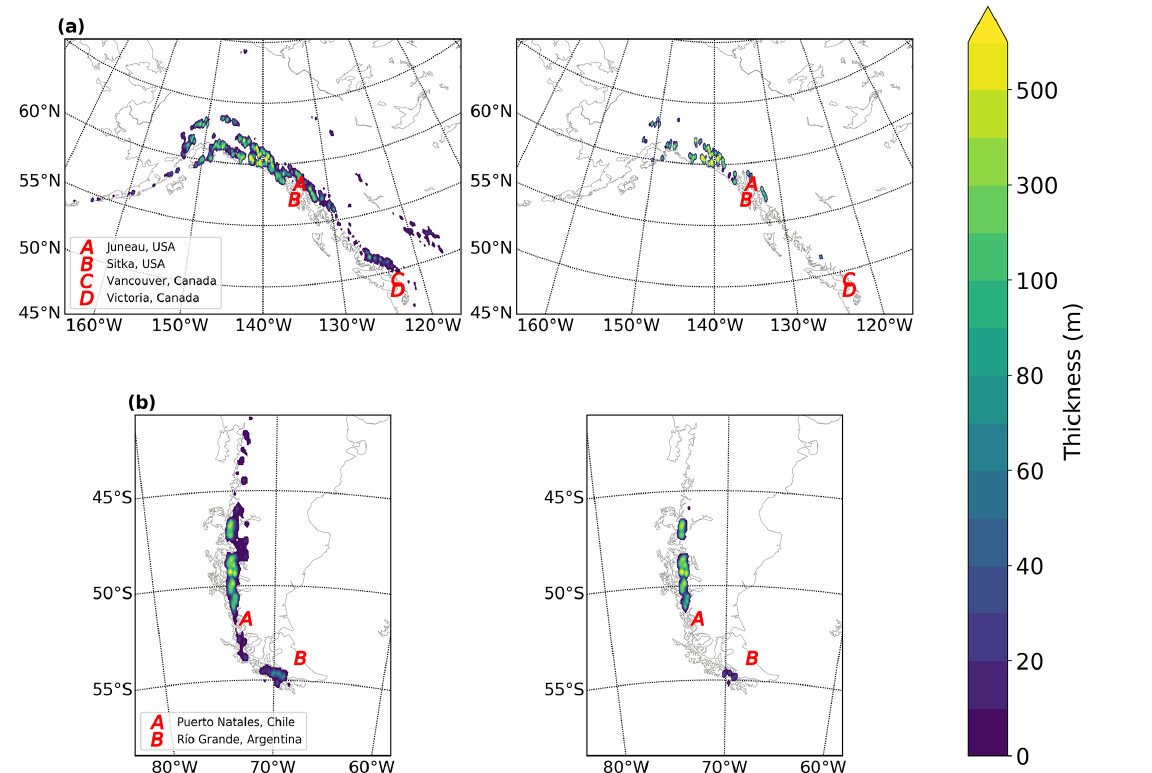
Figure 1. Estimated spatial distribution in ice thickness in RGI regions 1 and 2 (a) and 17 (b) at the beginning (2010CE, left) and end (2100CE, right) of the time period considered. The locations of population centres for which relative sea-level curves are calculated (see Figs. 5 and 6) are indicated by the red